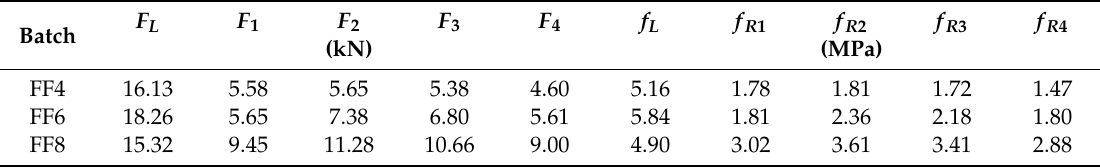
Table 5. Summary of 28-day flexural test results. Average flexural strength f L and residual flexural strength f Rj